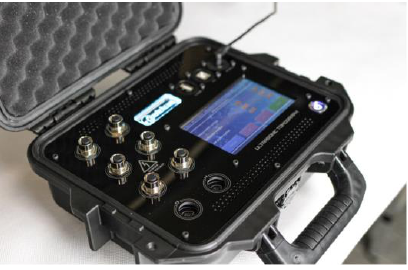
Figure 2. The schematic view of the ultrasound reflective tomograph.